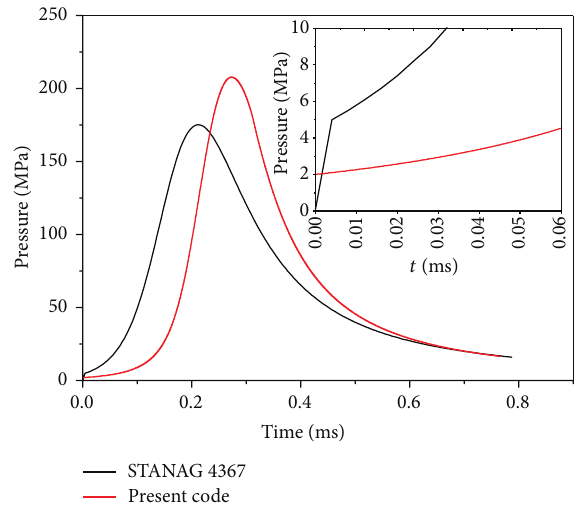
Figure 10: Shot base pressure-time history for 𝑚 𝑝 = 0.245 g, with barrel